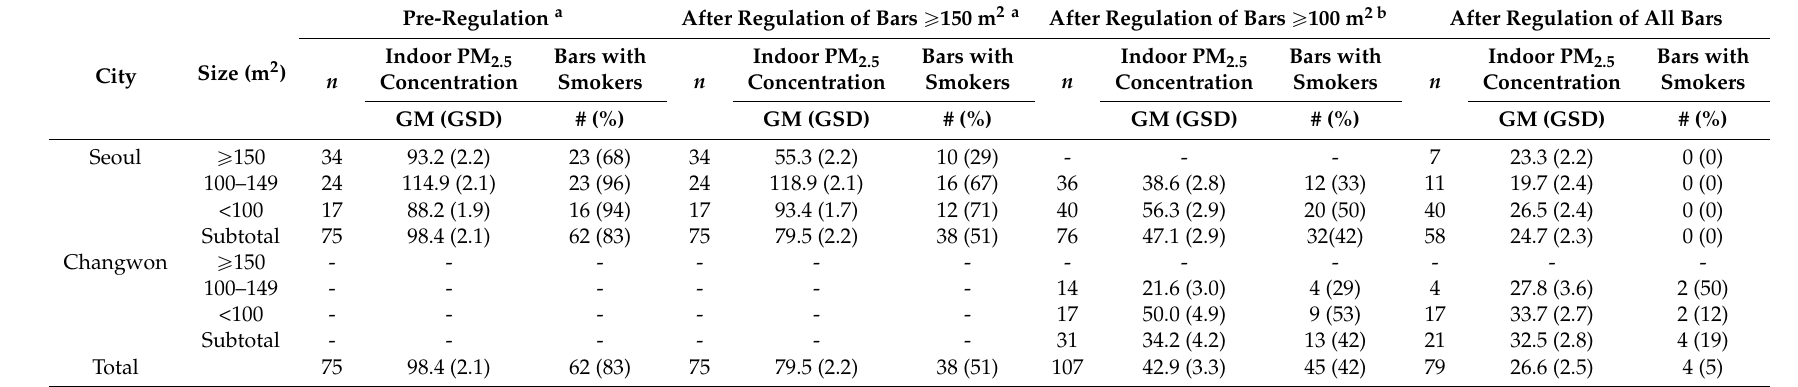
Table 1. Indoor PM 2.5 concentrations ( µ g/m 3 ) in bars and number of bars in which smokers were observed before and after smoke-free regulations were implemented in bars ě 150 m 2 , bars ě 100 m 2 , and in bars of all sizes in Seoul and